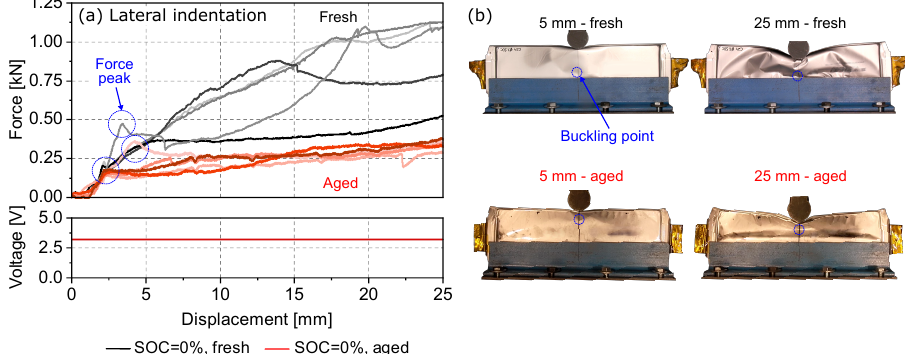
Figure 5. Comparison of the lateral indentation test results between fresh and aged lithium-ion cells: ( a ) shows the measured results of force and electrical voltage. ( b ) shows the buckling behavior of fresh and aged cells at 5mm and 25mm